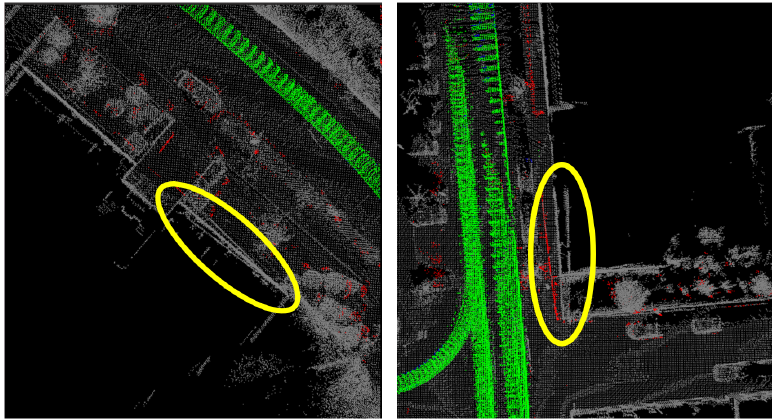
Figure 11. Regions enclosed by the yellow ellipse should correspond to a wall, but three walls appear in the figure, possibly due to the wrong intra-frame compensation of the original LiDAR